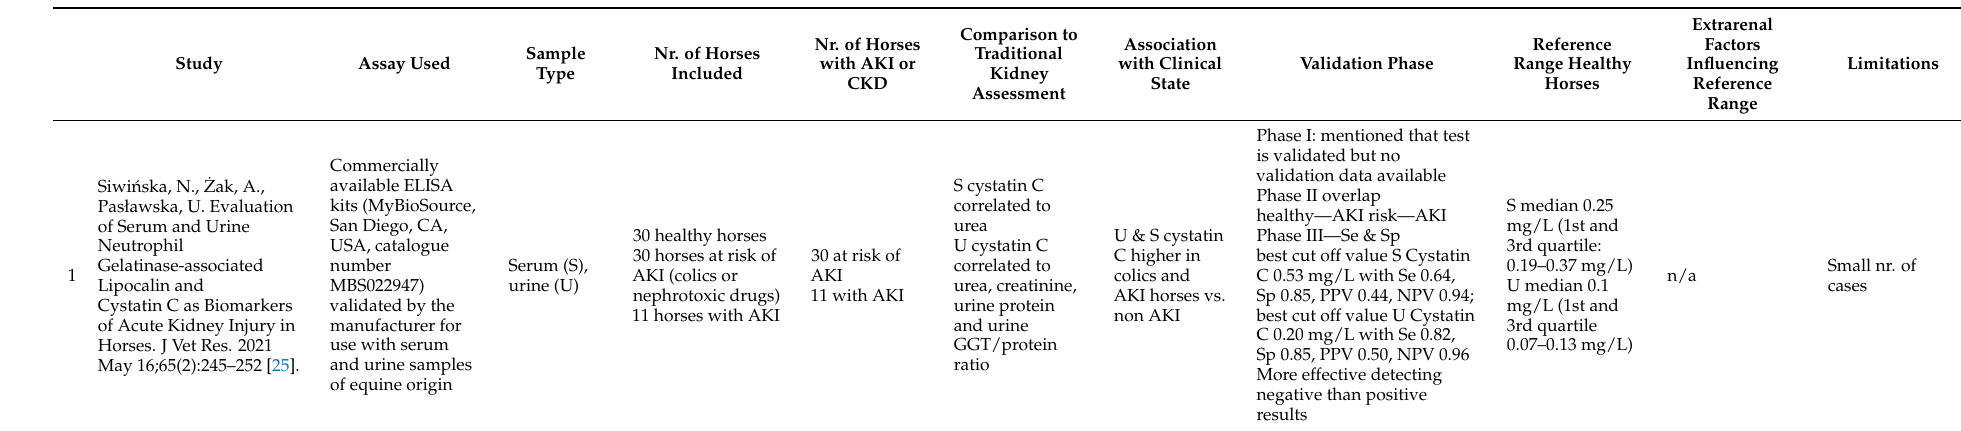
Table 3. List of studies on cystatin C and their analytical and clinical